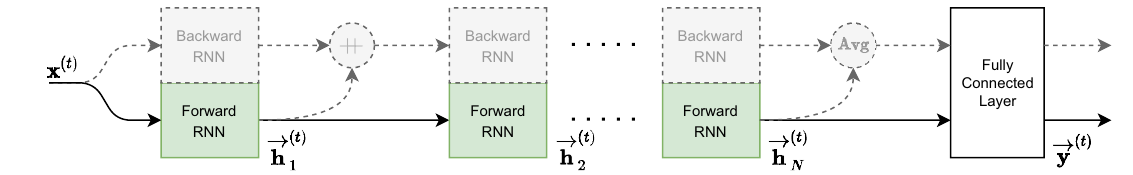
Figure 2. Graphical model of the forward step. The backward step is grayed out.